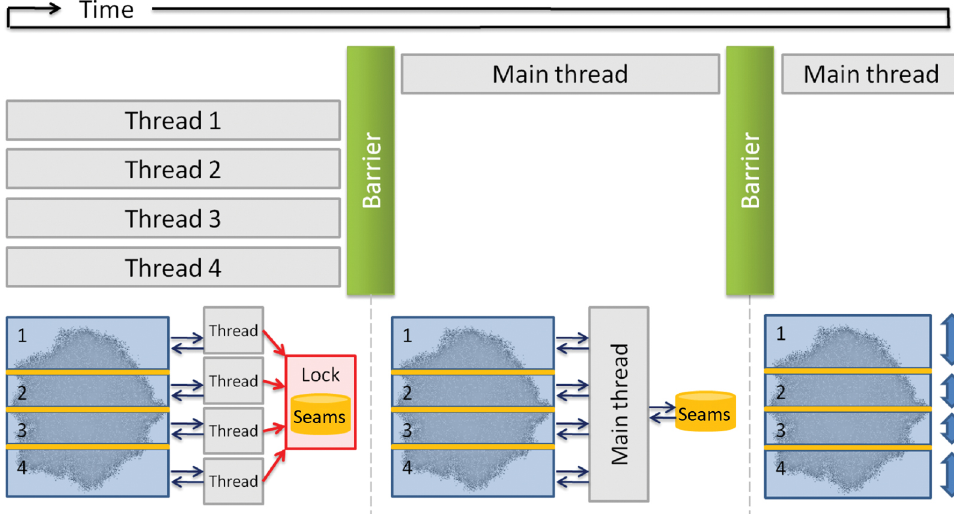
Figure 2: Tumoral growth parallel